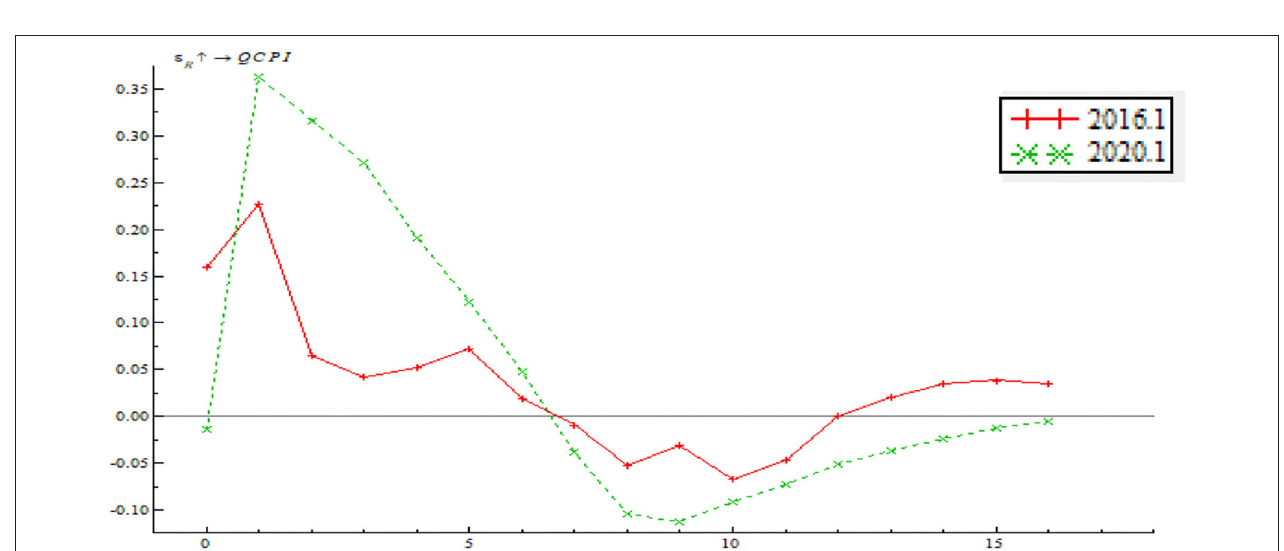
FIGURE 15 | Time point-based shock of price-based monetary policy on inflationary